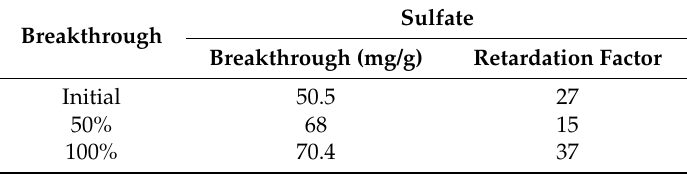
Table 3. Sulfate properties determined from 1D column test with Purolite